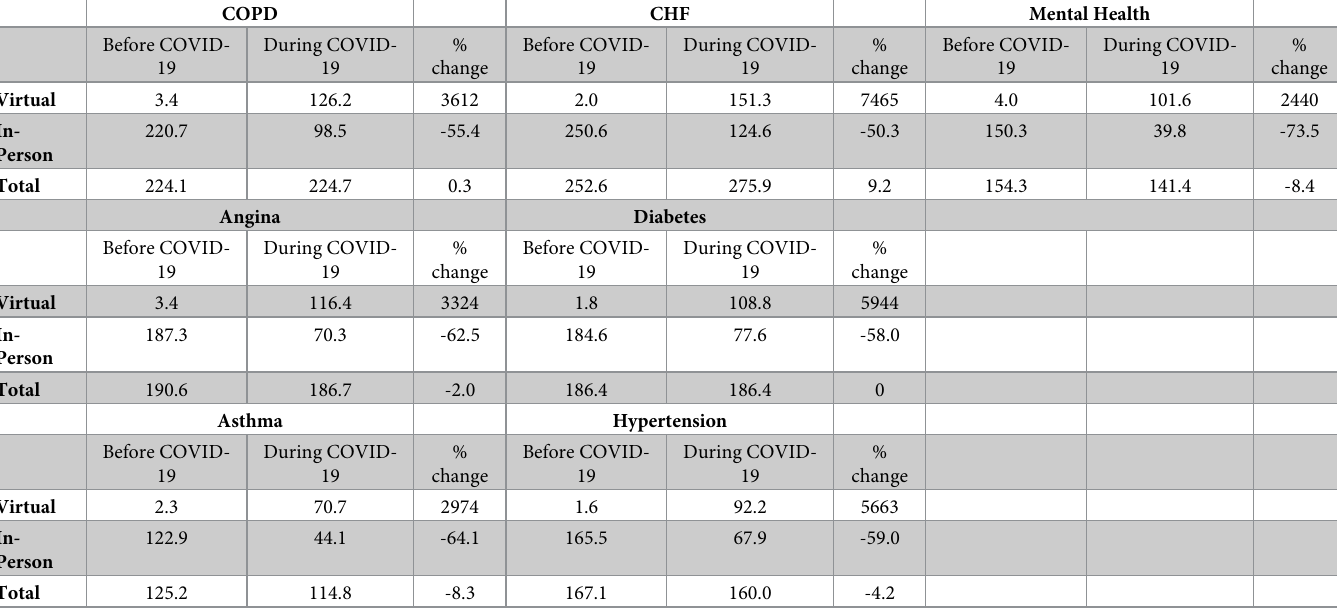
Table 1. Average weekly visit rates per 1000 patients by modality (virtual or in-person) before (Jan 2018 to Mar 2020) and during (Mar 2020 to Jan 2021) the pan- demic across chronic conditions.